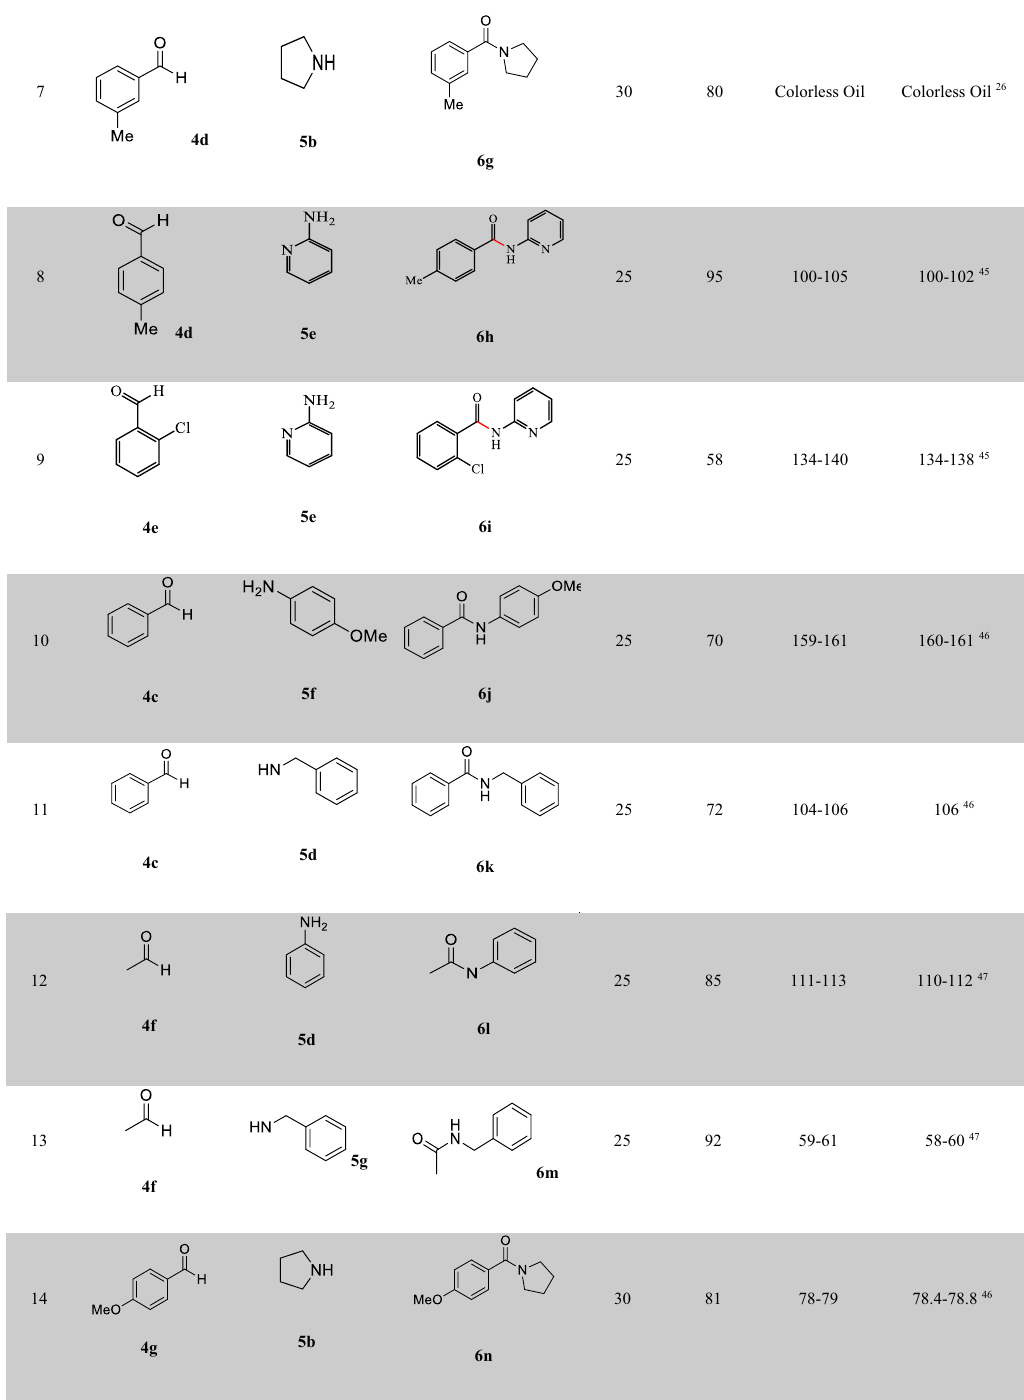
Table 4. Oxidative C − N coupling for synthesis of amides catalyzed by Cu@Sal-CS a . a Aldehyde (1